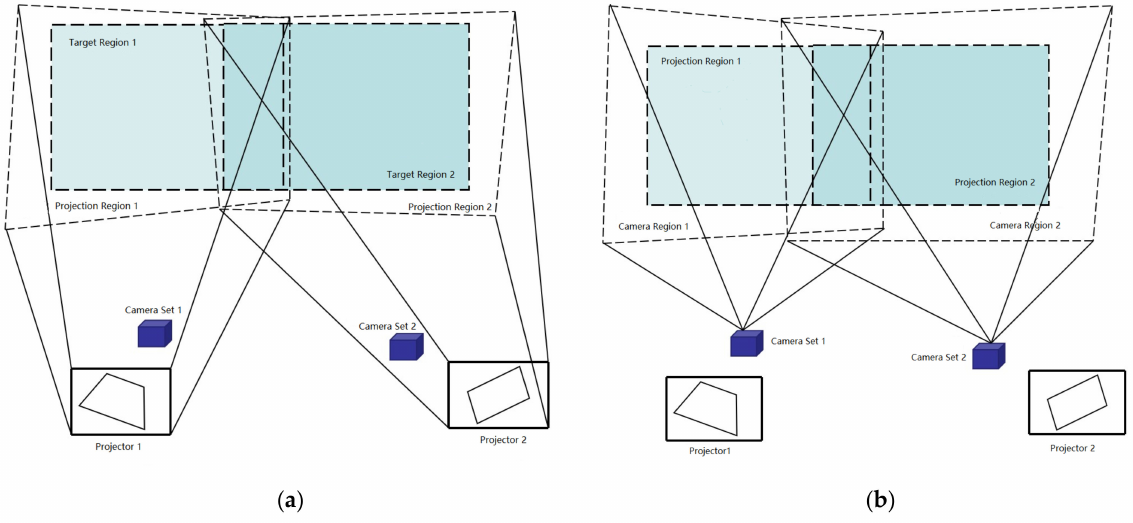
Figure 3. Dual-channel projector and binocular camera projection and shooting area: ( a ) projector projection area, and ( b ) binocular camera shooting